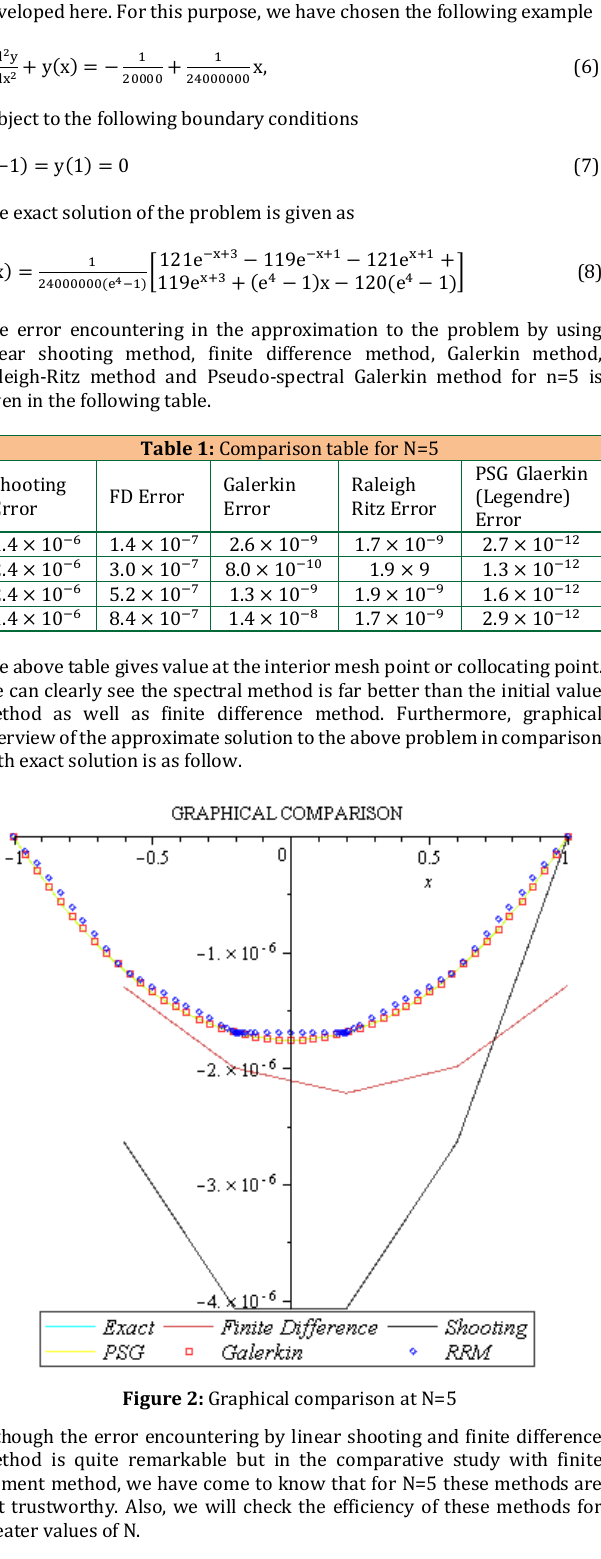
Table 2: Comparison table for